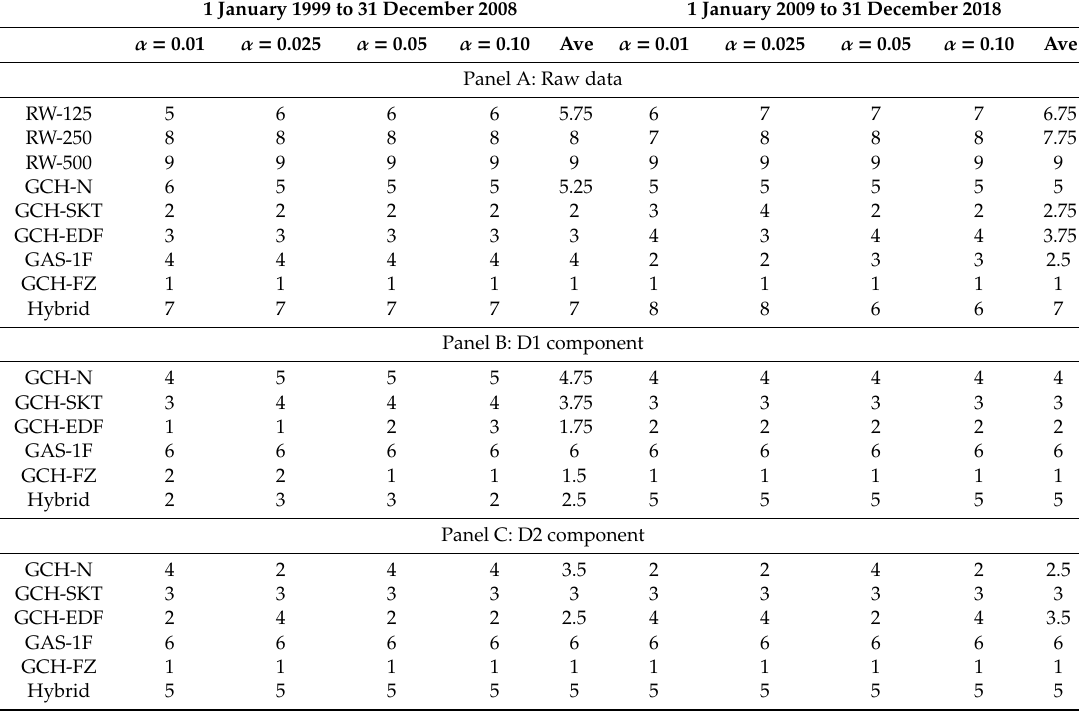
Table 10. The out-of-sample performance rankings for various alpha values based on the WTI